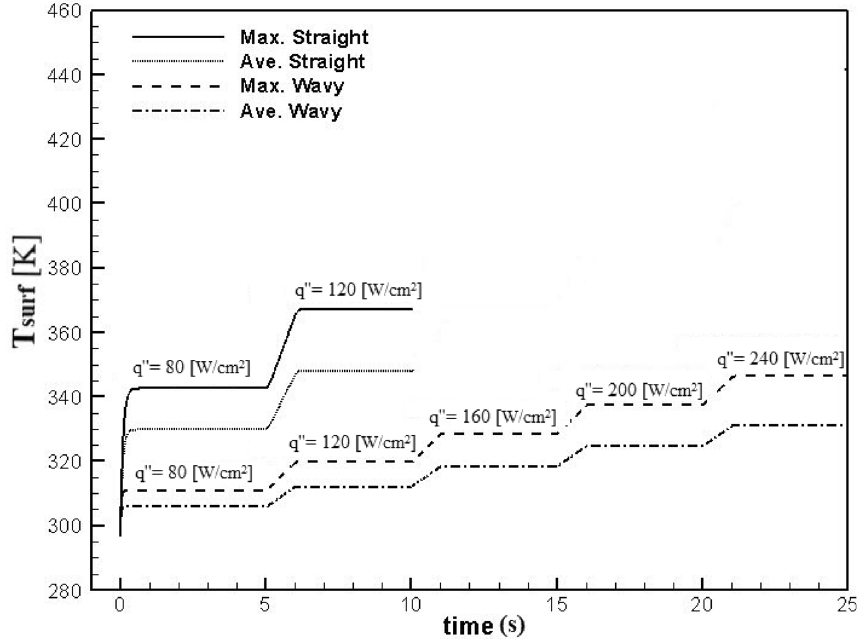
Figure 16. Maximum and average surface temperature versus time for the wavy case 3 and straight microchannel at Re = 900 for different heat